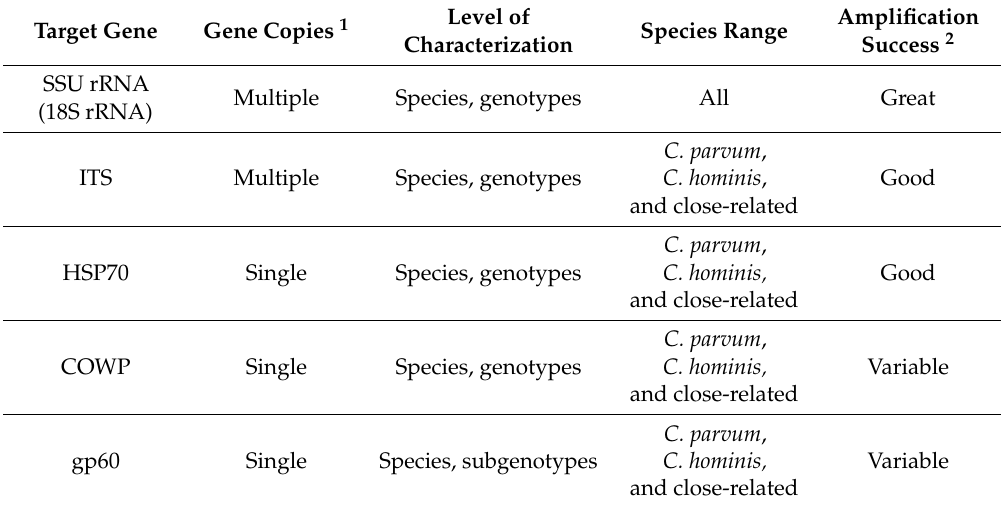
Table 1. Target genes used in Cryptosporidium spp. characterization. Adapted from